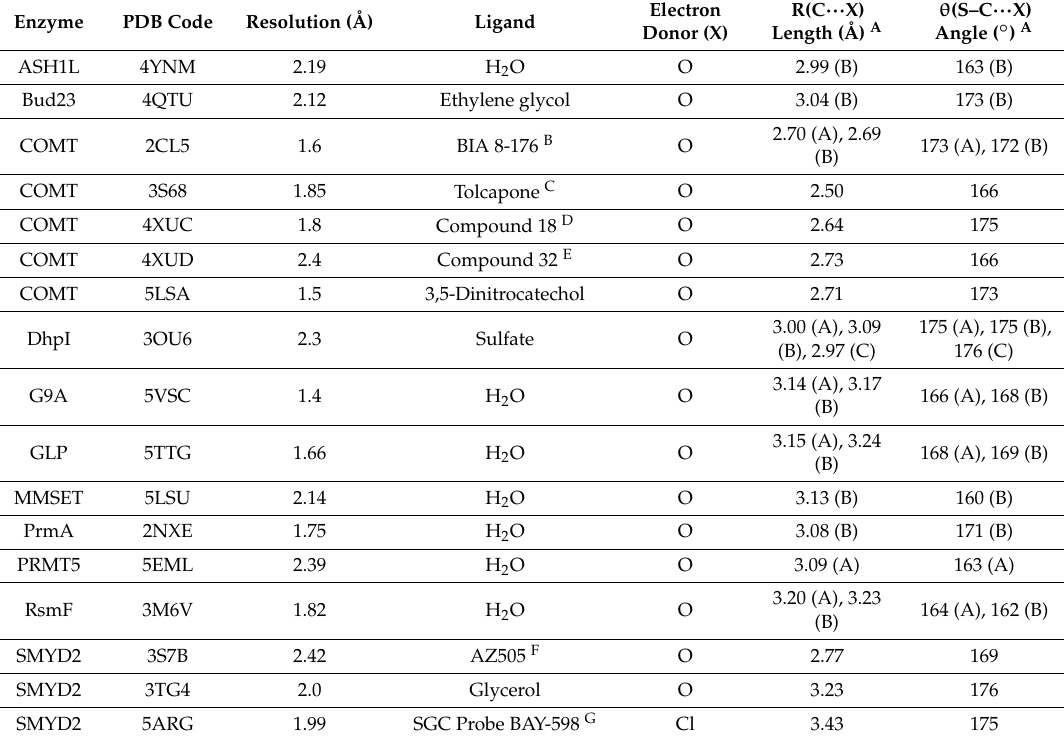
Table 1. Crystallographic survey of methyl tetrel bonding in AdoMet-dependent methyltransferases.